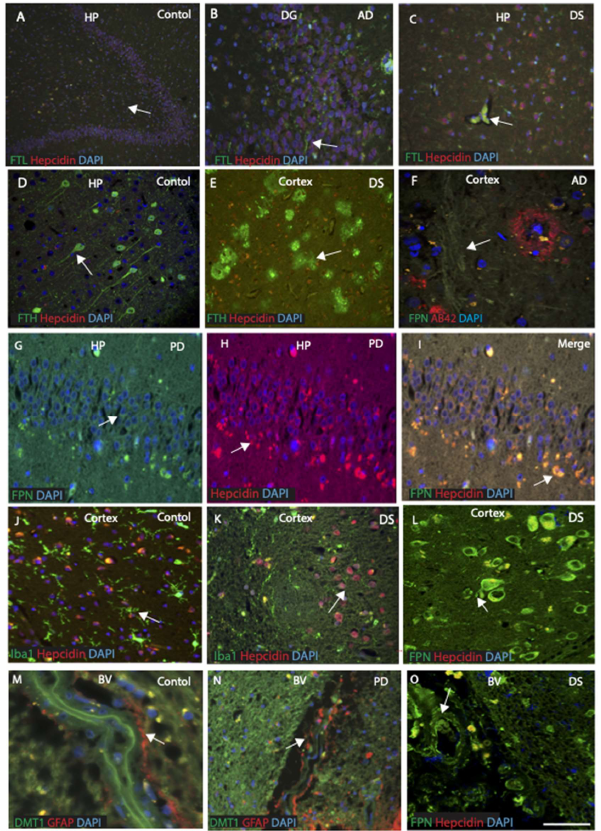
Figure 6. Cellular localisation of ferroportin and hepcidin in the cortex. Fluorescent double staining of hepcidin and FTL was performed using brain sections from cortex and analysed with confocal microscopy. In control brain, hepcidin (red) and FTL (green) were present in the hippocampus and higher magnification in the AD brain showed microglia stained with FTL and hepcidin was located in the granule cell layer ( A , B ). Most of the FTL positive microglia (green) were located in the vicinity of the blood vessels and some protein found entering the brain parenchyma from blood vessels (shown with an arrow ( C ). In control brain sections from HP and DG, when stained with FTH, strong FTH staining was visible in the pyramidal neurons ( D ), whereas in DS subjects, FTH was present in the senile plaques and hepcidin in the peripheral cells ( E ). In AD brain, Aβ42, staining was visible in the senile plaques in cortex, but ferroportin was present in the axon/dendrite filaments ( F ). One PD brain (HP) section was stained with ferroportin and hepcidin and analysed with confocal microscope, and both proteins co-localised in the HP ( G – I ). Control and DS brain sections were stained with microglia marker (Iba1) and hepcidin. In control brain, ramified microglia (green) and hepcidin (red) were visible without co-localisation ( J ), and in DS brain, activated microglia was present surrounding the plaques while hepcidin was seen in the surviving neurons ( K ). In the DS brain in cortex, ferroportin was expressed in the neurons and there was some localisation with hepcidin ( L ). In control blood vessels, DMT1 expressed in the endothelium of blood vessels and strings of GFAP positive astrocytes appeared probably to receive and transport the proteins into the brain parenchyma ( M ). In PD brain, the blood vessels appeared severely damaged and endothelium significantly losing its structure ( N